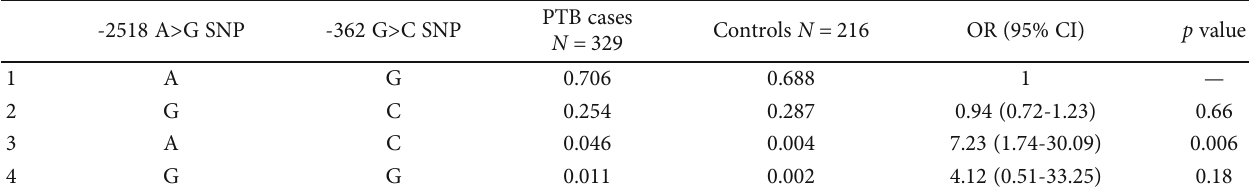
Table 3: Haplotype analysis for -2518 A > G and -362 G > C polymorphism in PTB cases and controls. -2518 A > G